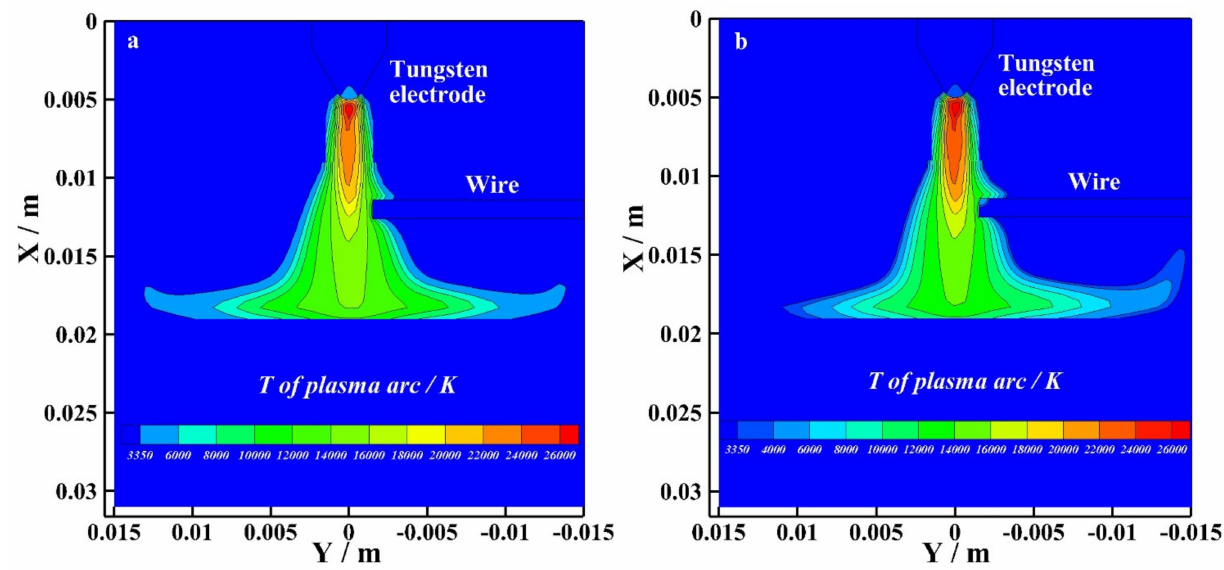
Figure 7. The temperature distribution at EN phase with and without bypass current, ( a ) 120 A and 0 A, ( b ) 60 A and 60 A.